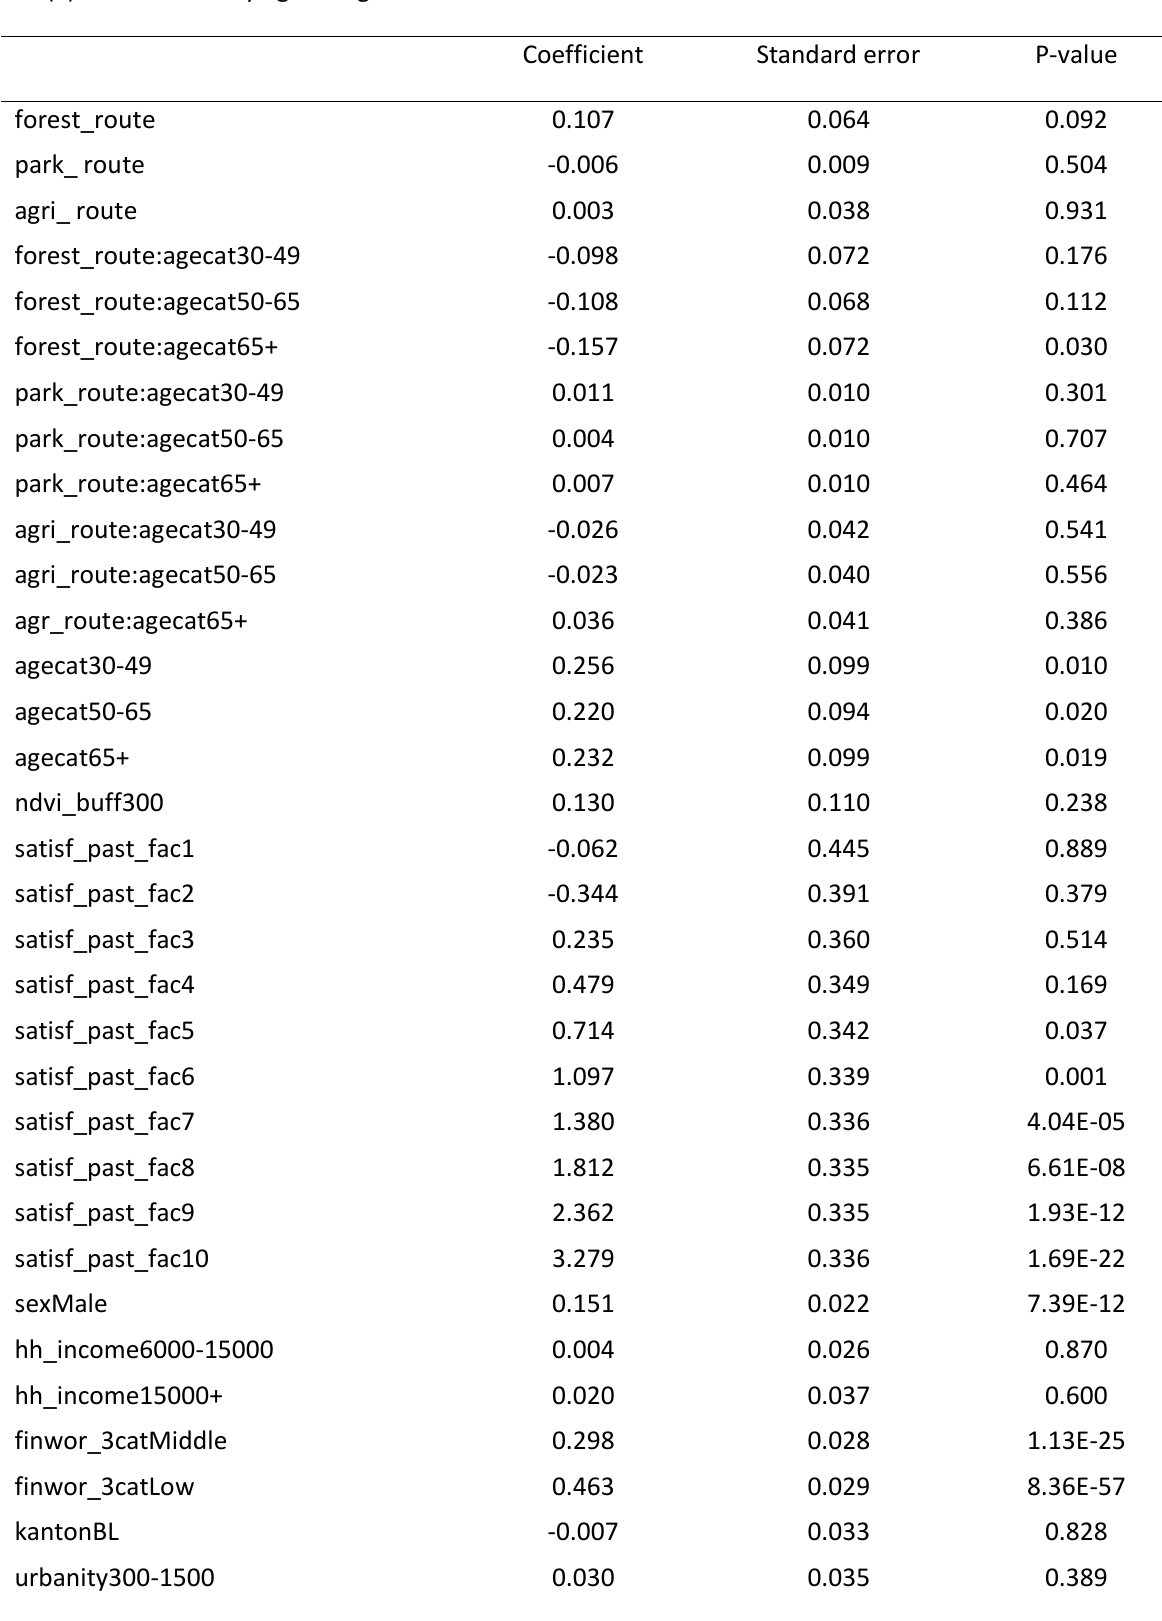
Table S7 . Results from ordered probit regression of life satisfaction on proximity to greenspace (a) by age categories, (b) by household income, (c) by financial worries, adjusted for life satisfaction in the past, age categories, sex, household income, financial worries, canton, degree of urbanisation, month of entry, and